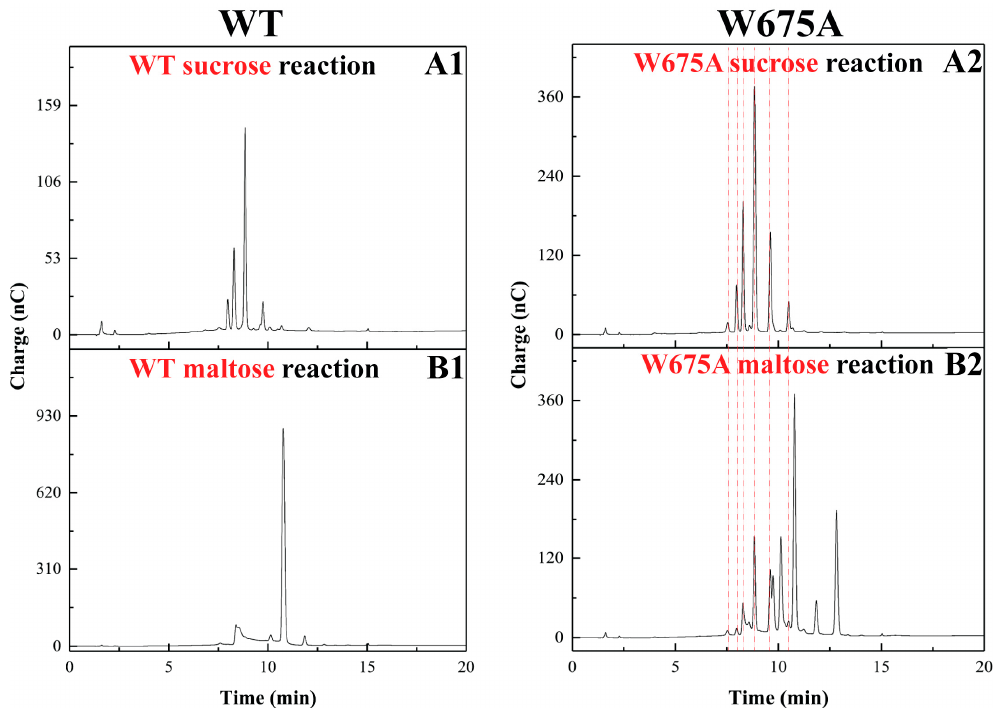
Figure 5. Comparison of trisaccharides from WT and W675A. Purified trisaccharides from sucrose and maltose acceptor reaction as analyzed by HPAEC-PAD. Mass verified by MALDI-TOF MS. ( Left panel ): trisaccharides from WT alternansucrase. ( Right panel ): W675A. ( A ) Trisaccharides from sucrose reaction. ( B ) Trisaccharides from maltose-acceptor reaction. Red dash lines indicate overlapping products from W675A sucrose and maltose reactions.